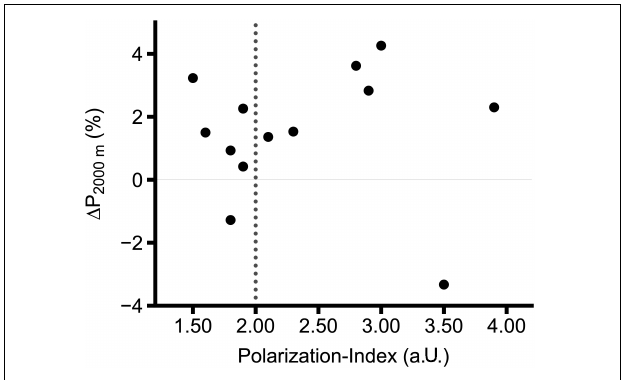
FIGURE 3 | Percentage change of average power in 2000 m rowing ergometer test (P 2000 m ) in internationally competing rowers. Vertical dashed line represents the cut-off between non-polarized ( ≤ 2.00 a.U.) and polarized ( > 2.00 a.U.) TIDs. Figure adapted from Treff et al.